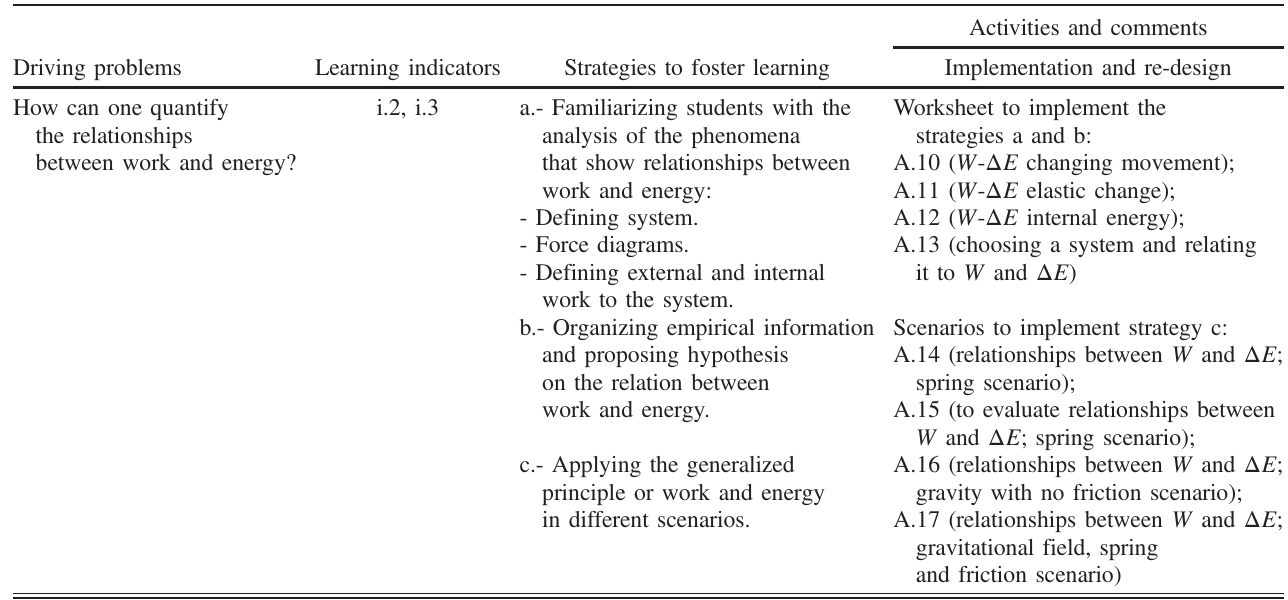
TABLE III. The section about “ How can work done on a system of particles and the energy that is transferred be measured? ” from the teaching-learning sequence on mechanical work and